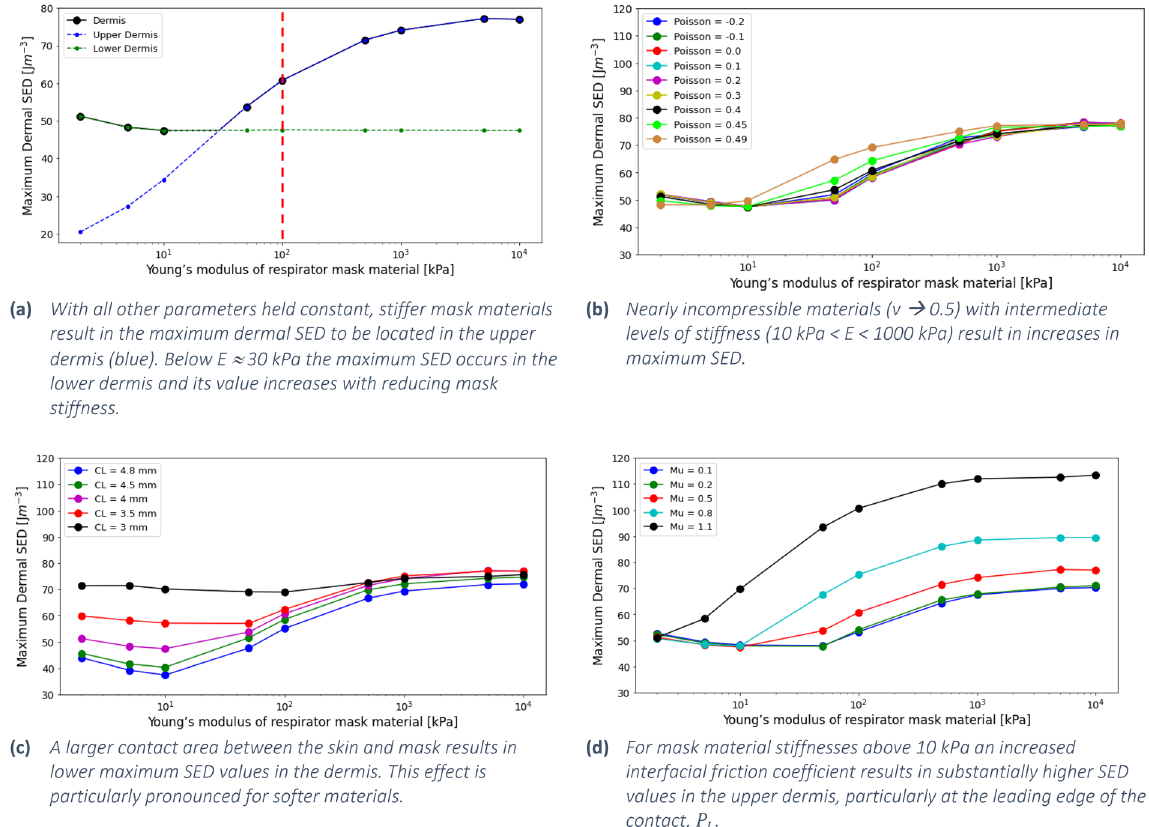
Figure 2. The effects of independently altering the mask properties on the maximum SED in the tissue. (a) Mask material stiffness, (b) Poisson’s ratio, (b) area of contact, and (d) interfacial friction